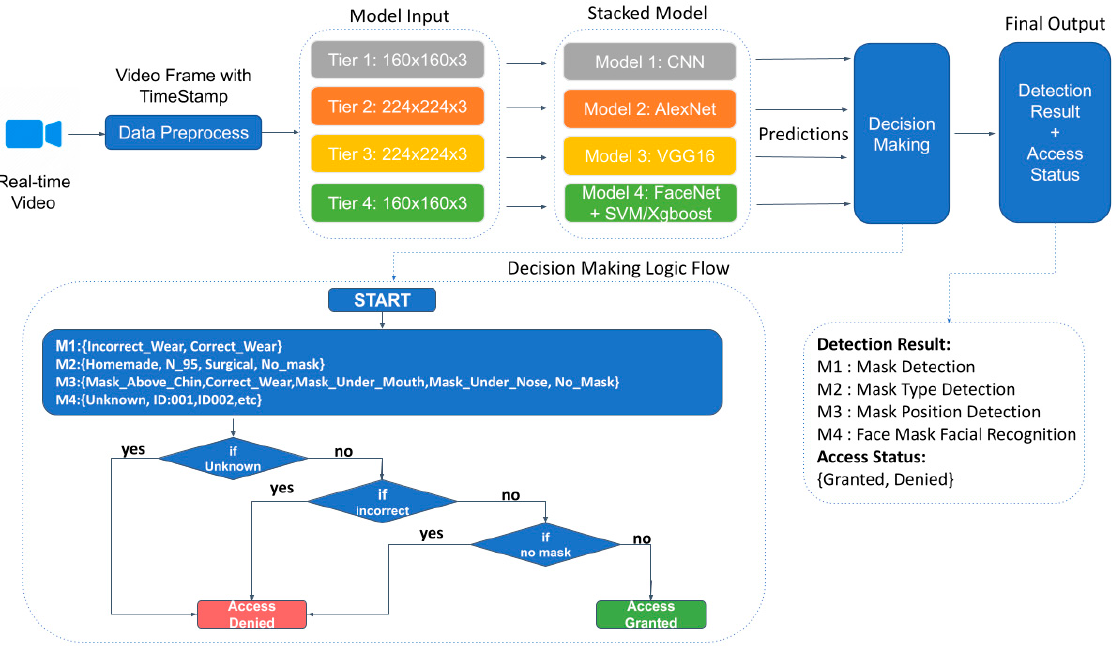
Figure 8. Stacked Model Working